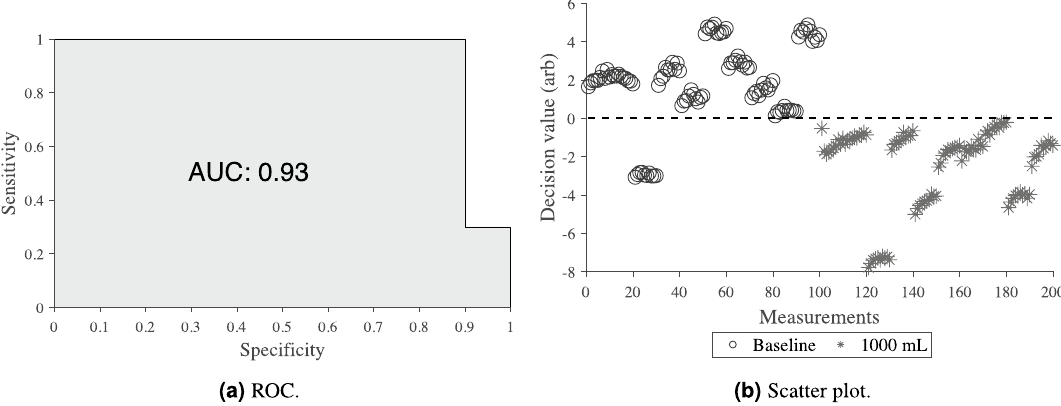
Figure 6. Receiver operating characteristic curve (ROC) ( a ) and scatter plot ( b ) of the best SVM classifier for differentiating 1000 mL hemoperitoneum from